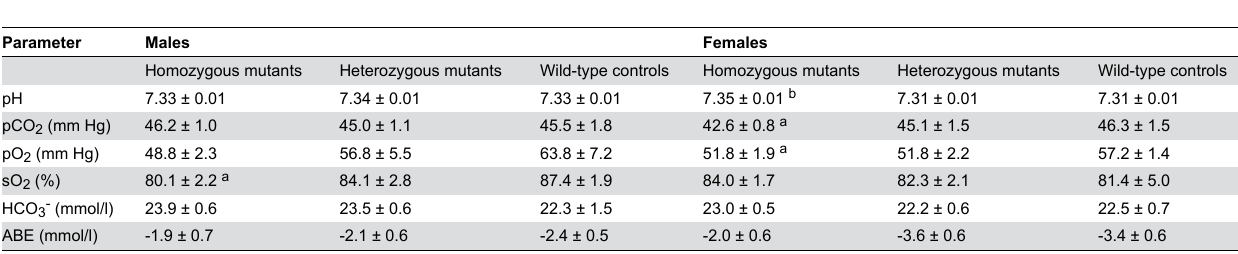
Table 2. Blood gas analysis of line Umod A227T at the age of 9 months.